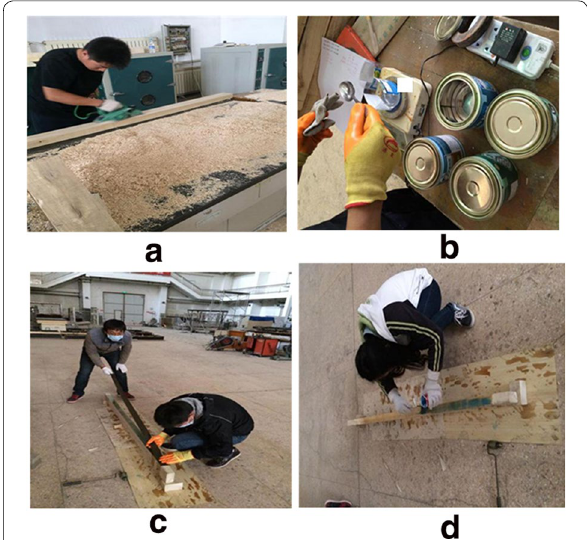
Fig. 4 Main procedure of strengthening BFRP: a smoothed surface of beam, b primer mixed, c primer and saturant painted, and d FRP